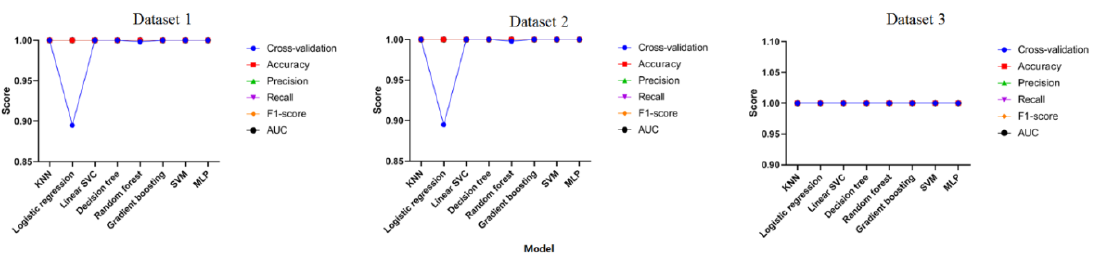
Figure 6. Performance evaluation results according to Datasets 1 to 3 with the elapsed time and flag.